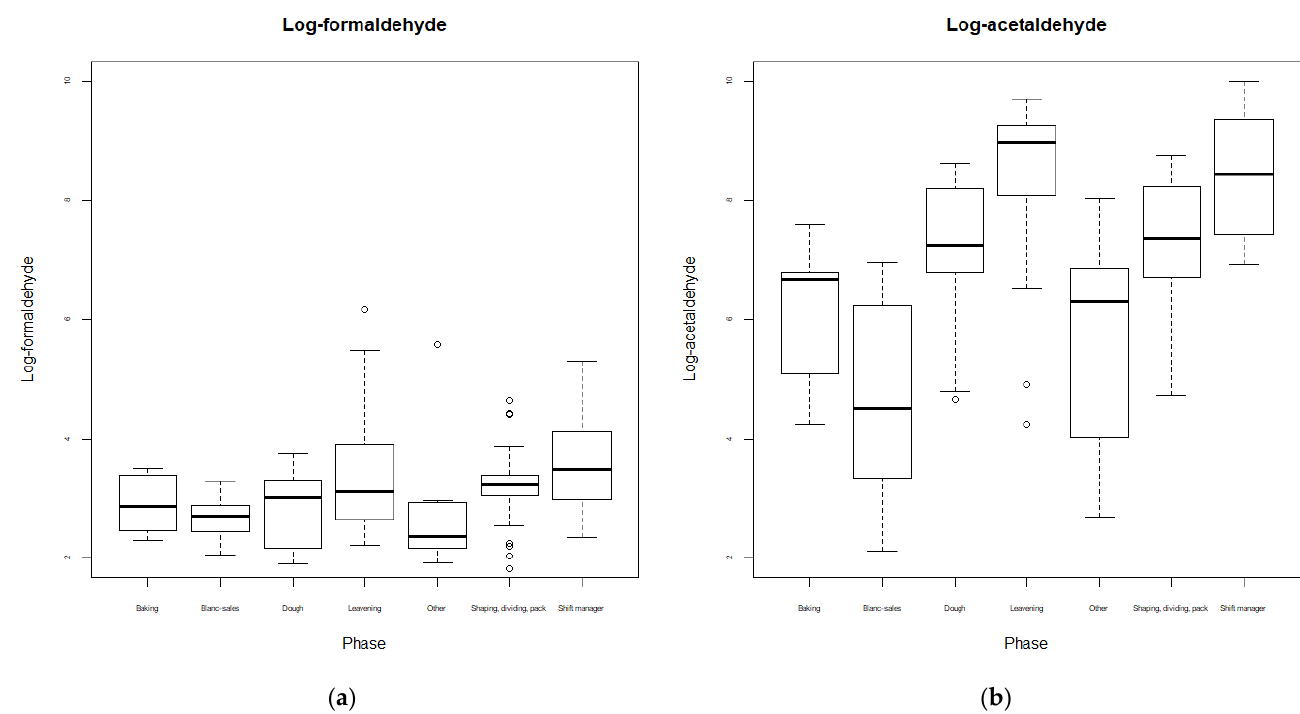
Figure 2. The boxplots show the level of log-formaldehyde by the phase of the production cycle (a) and log-acetaldehyde by the phase of the production cycle (b).